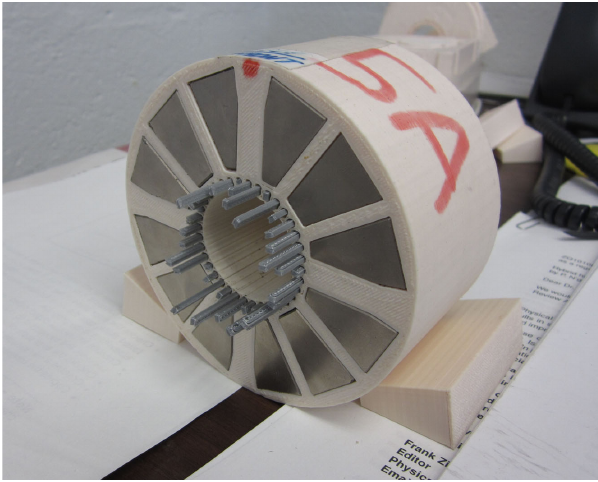
FIG. 13. R&D permanent magnet quadrupole “ 5A ” .